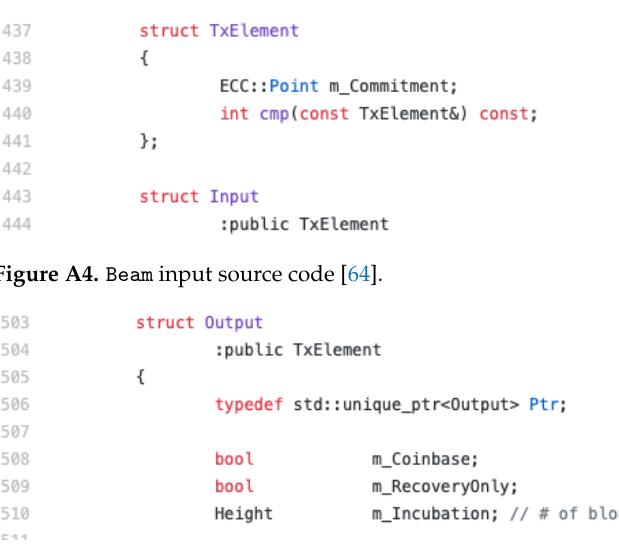
Figure A5. Output incubation period source code